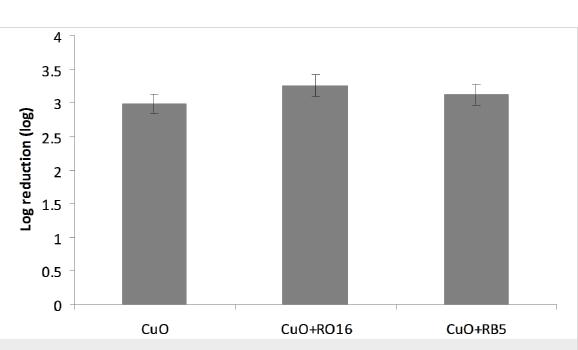
Figure 6: Antibacterial properties of ZnO-coated bandages and ZnO/dye-coated bandages.